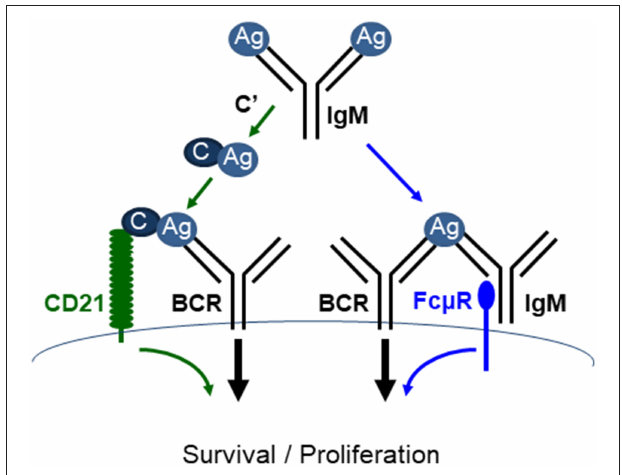
FIGURE 4 | Fc µ R and complement receptor promote mature B cell survival and activation. IgM (pentamer; for simplicity a monomeric IgM is depicted) binds to antigens (Ag) and the resulting IgM-Ag complexes can enhance B cell survival and activation through at least two pathways. (1) IgM-Ag complexes can activate complement (C’) cascade, resulting in C’ fixation on the Ag, which can crosslink BCR and C’ receptor (CD21) on B cells (green arrows). (2) IgM-Ag complexes can crosslink BCR and Fc µ R on B cells (blue arrows). It remains to be elucidated whether these two pathways function cooperatively, independently or competitively [adapted from Ouchida et al. (